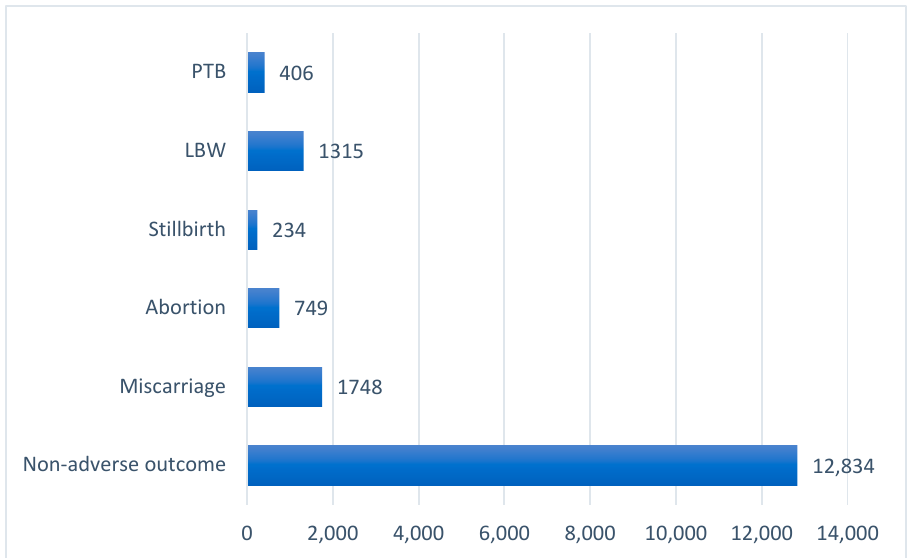
Figure 1. Number of women in different birth outcome categories.